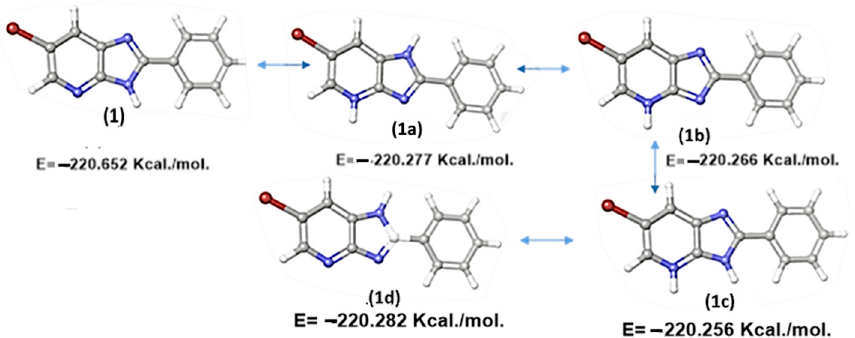
Figure 6. Optimized structures of the tautomeric structures ( 1 – 1d ) .